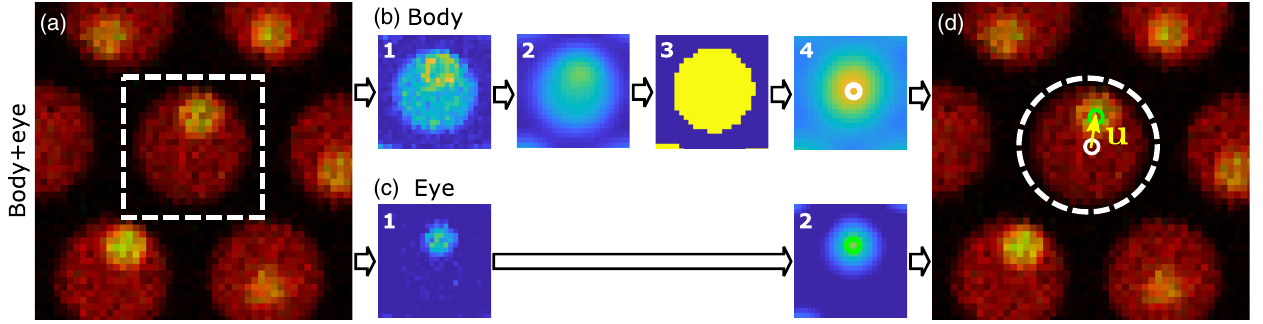
FIG. 2. Orientation vector location from confocal microscopy. (a) Composite image of a single slice from a two-channel 3D-CLSM stack. (b) Particle location for the particle body. The raw data for the corresponding channel (1) are band passed (2), binarized (3), and then resmoothed (4) before a particle location algorithm is applied [point in (4)]. (c) Particle location for the particle eye. The raw data for the corresponding channel (1) are band passed (2) before a particle location algorithm is applied [point in (2)]. (d) Body and eye positions are associated via a simple distance threshold (dashed circle) and joined to give a particle-specific orientation vector, u